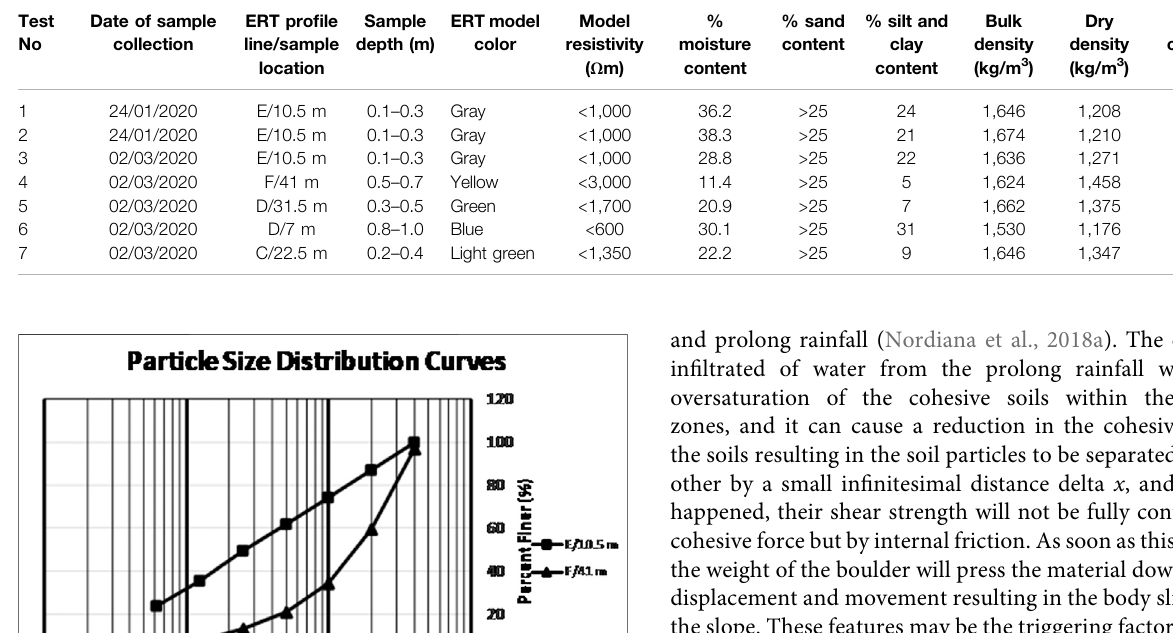
TABLE 4 | Summarized geotechnical parameter test